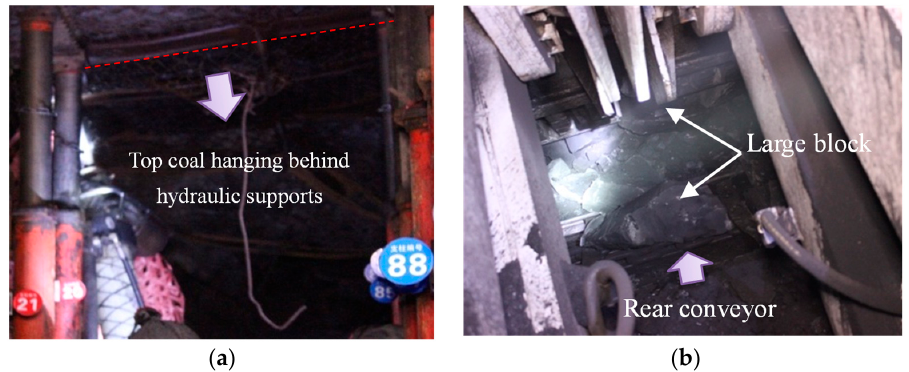
Figure 2. Undesired caving behaviors of top ‐ coal. ( a ) Delayed caving; ( b ) formation of the large top ‐ coal block.